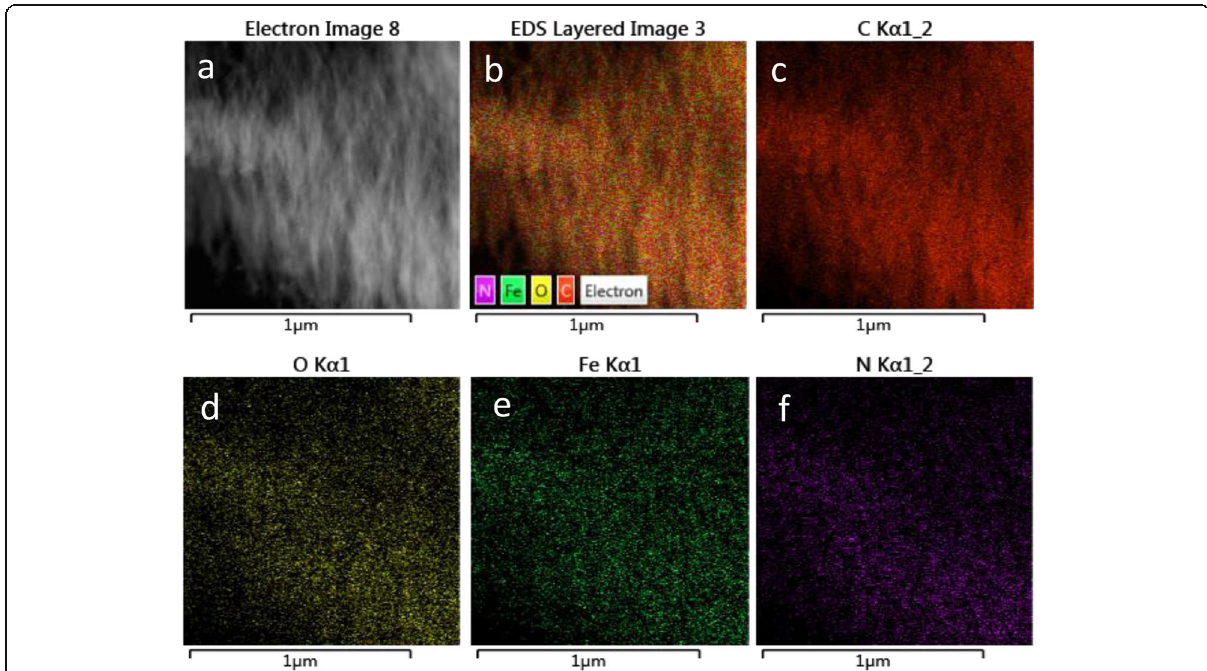
Fig. 7 TEM image ( a ) of m -Fe/N/C-900 and corresponding elemental mapping images of C, O, Fe, and N ( b – f